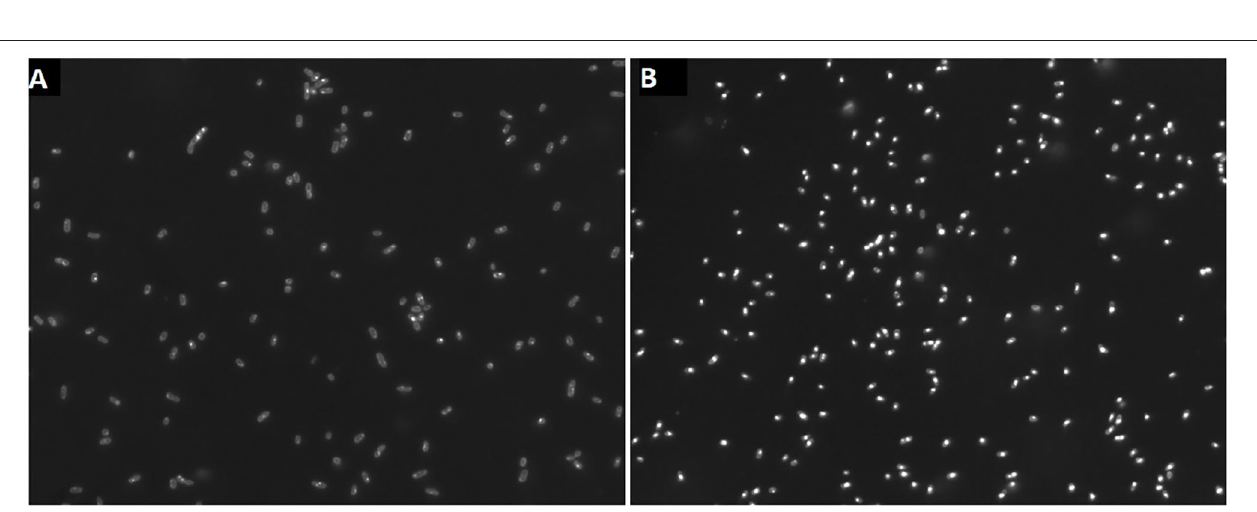
FIGURE 4 | Cells grown at 2 M NaCl (A) and at 0.17 M NaCl (B) stained with nile red to show PHB granules.